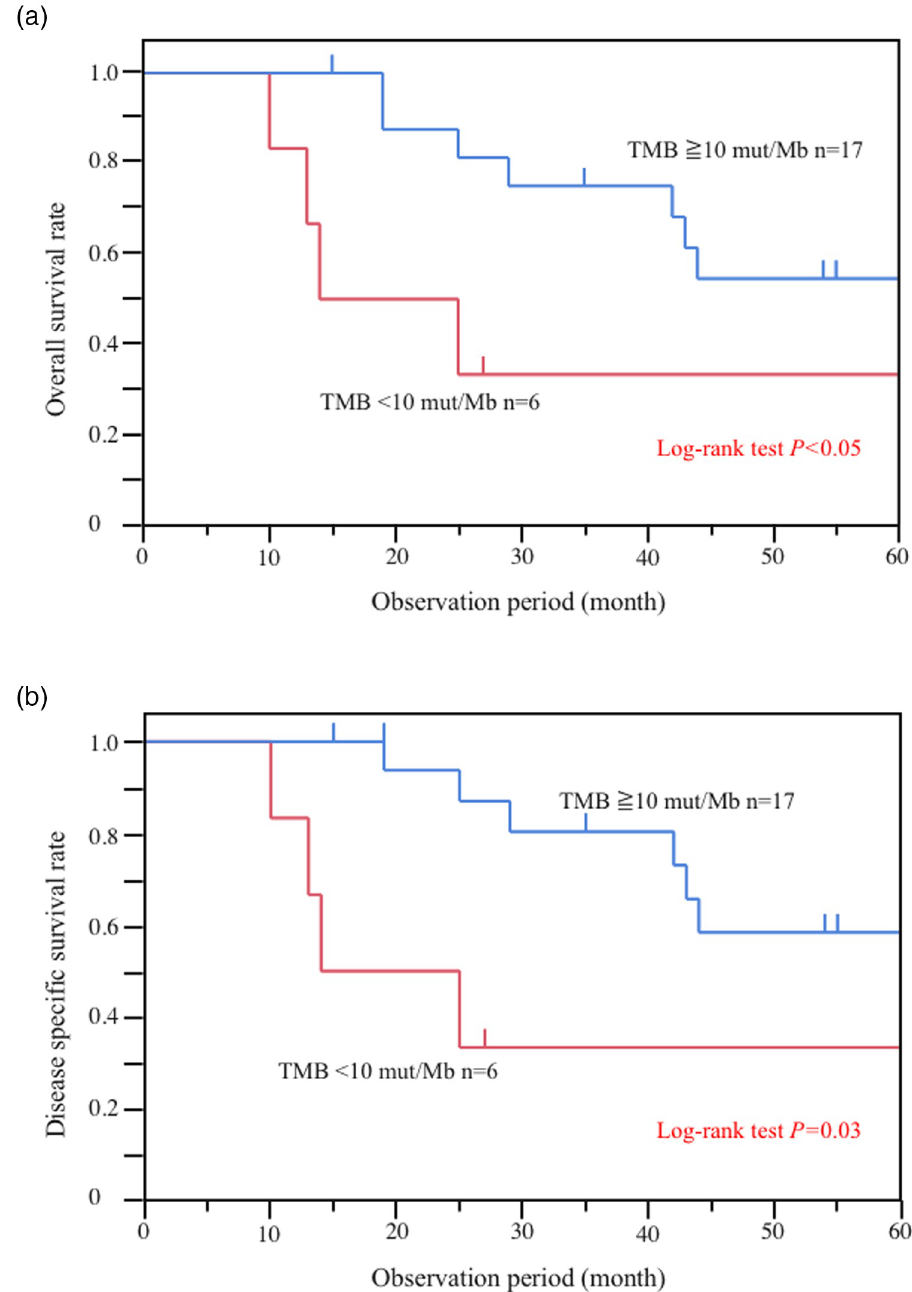
Fig 2. Analysis of Overall Survival (OS) and Disease-Specific Survival (DSS) for patients with small-bowel cancer according to Tumor Mutational Burden (TMB). ( a ) OS of patients with small-bowel cancer according to TMB [TMB < 10 mutations/megabyte of DNA (mut/Mb) vs TMB � 10 mut/Mb, P < 0.05]. ( b ) DSS of patients with small-bowel cancer according to TMB (TMB < 10 mut/Mb vs TMB � 10 mut/Mb, P = 0.03).